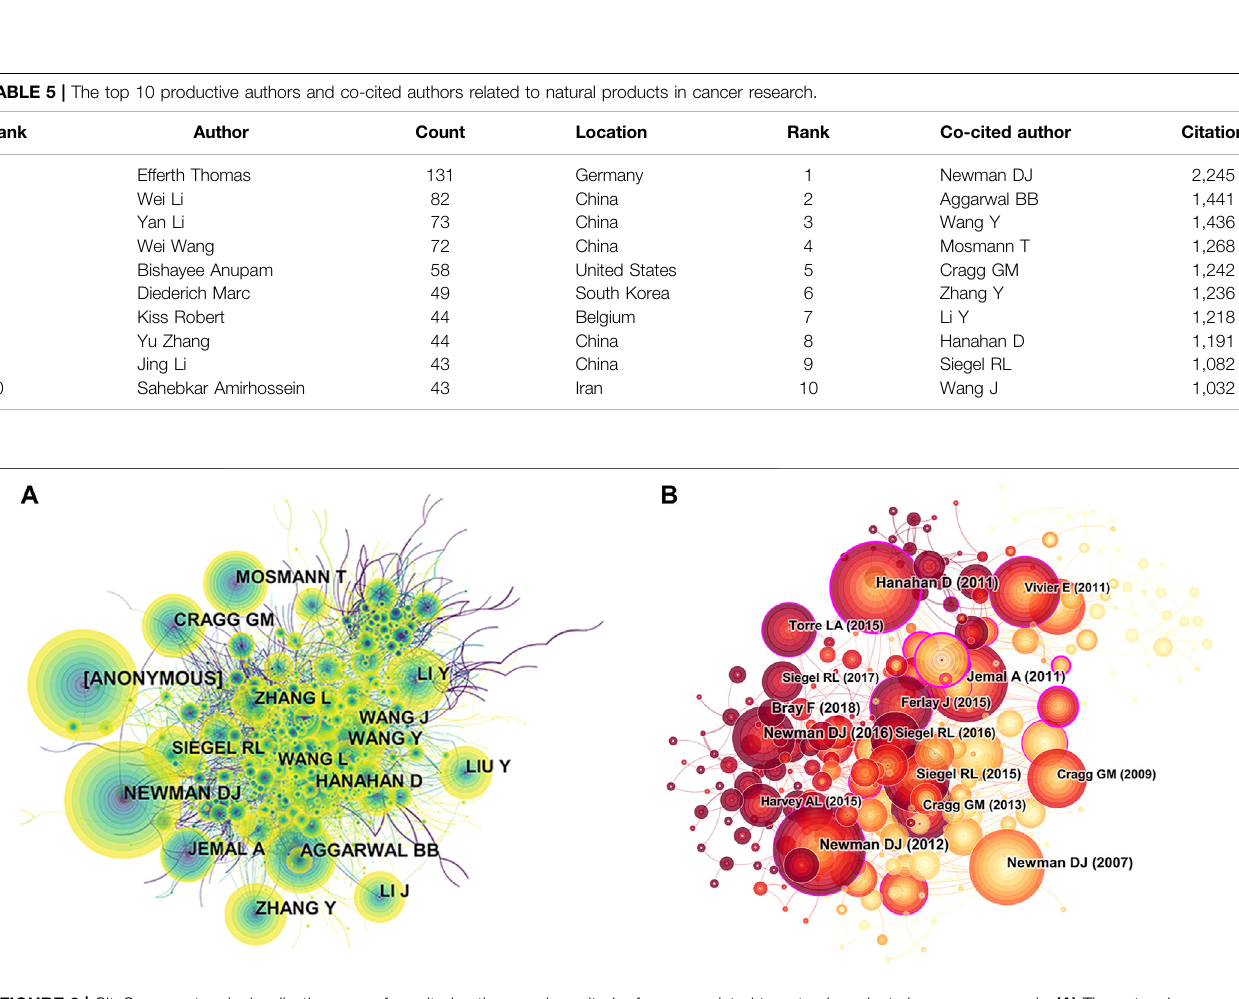
Frontiers in Pharmacology |